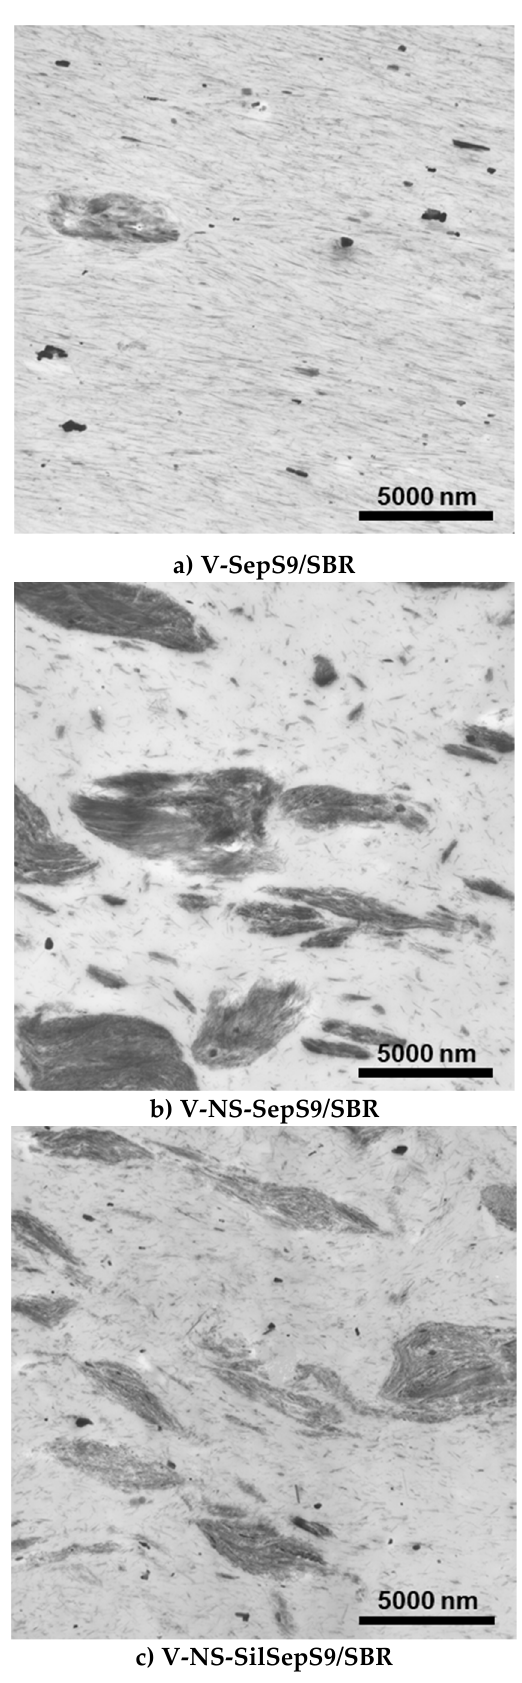
Figure 6. Transmission electron microscopy (TEM) images of ( a ) V-SepS9/SBR, ( b ) V-NS-SepS9/SBR, ( c ) V-NS-SilSepS9/SBR.